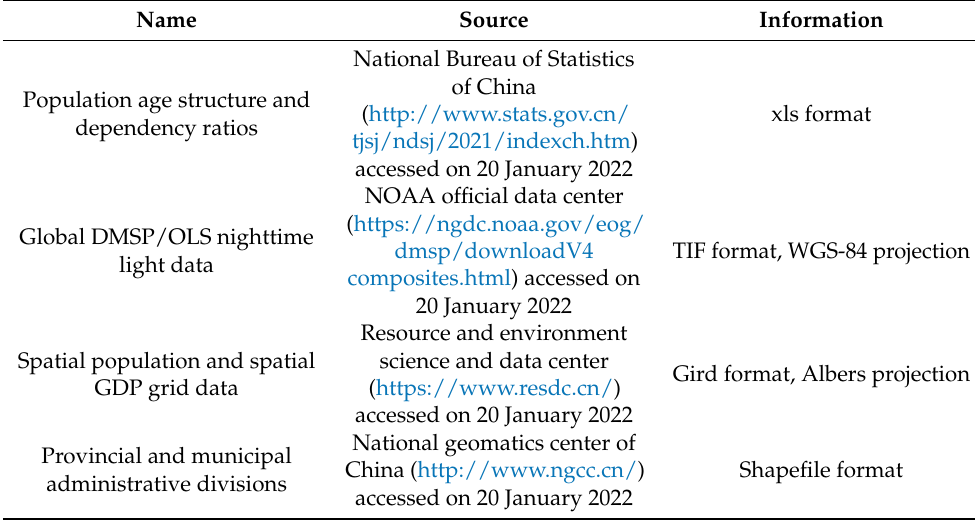
Table 1. Descriptions of data